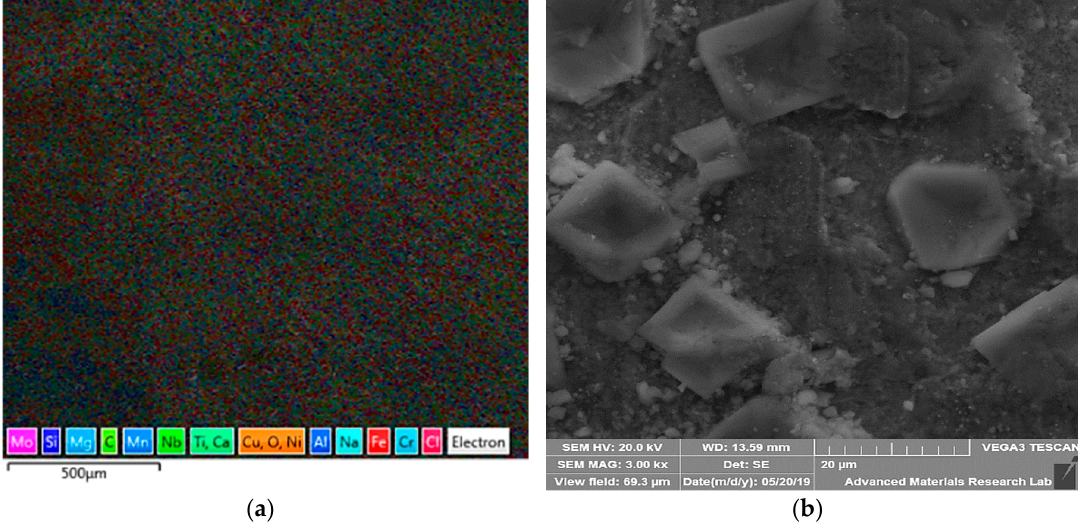
Figure 7. EDS and SEM for HT specimen; ( a ) specimen HT-EDS mapping for weld; ( b ) specimen HT-SEM on weld.